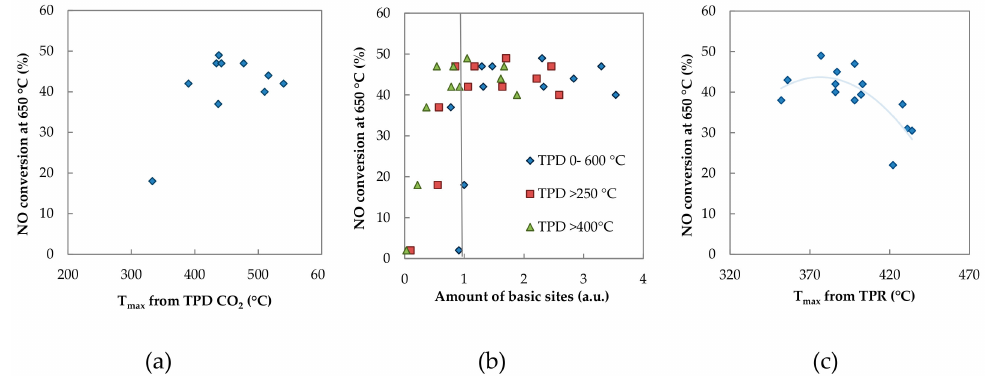
Figure 14. ( a ) The dependence of NO conversion on the temperature maximum of the main peak acquired from TPD CO 2 results, ( b ) the dependence of NO conversion on the temperature maximum of the main peak acquired from TPR-H 2 and ( c ) the dependence of the NO conversion on the amount of basic